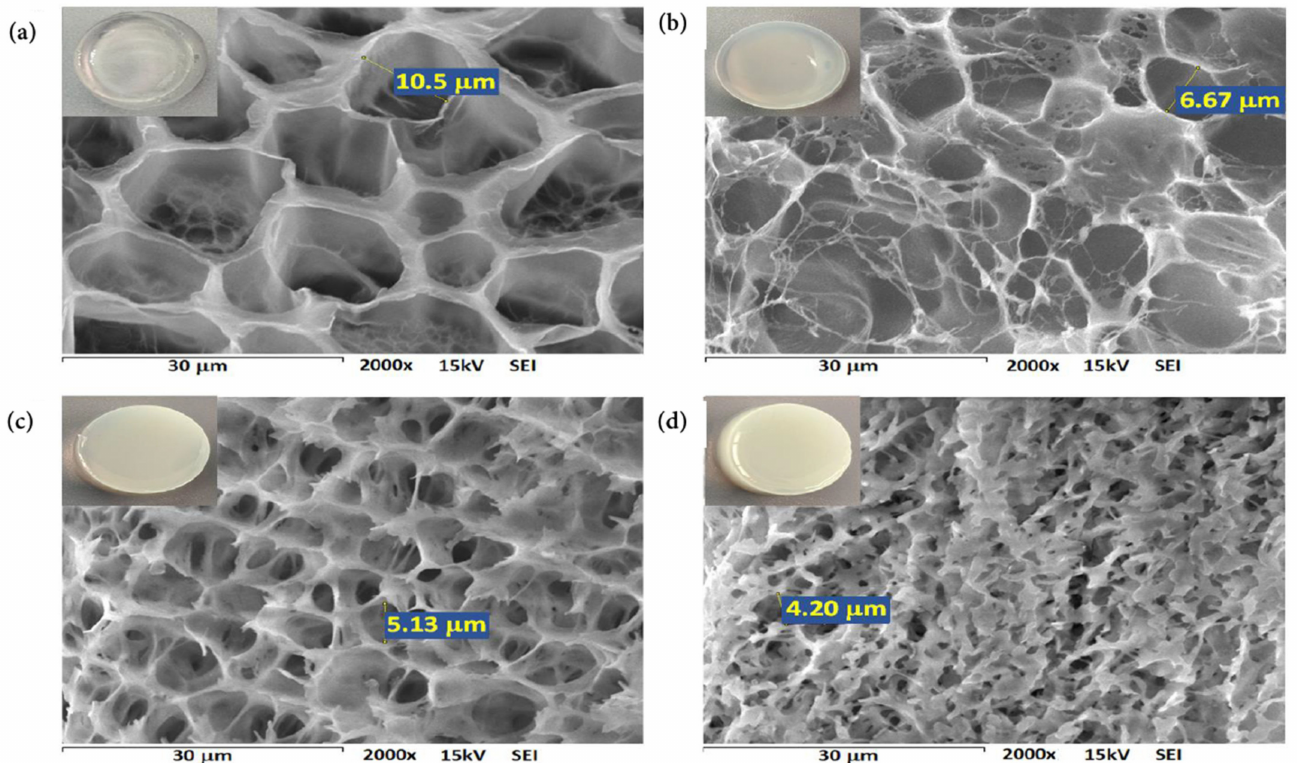
Figure 3. SEM micrographs of cross sections of PNIPAAm ( a ), s-IPN 1 ( b ), s-IPN 2 ( c ), and s-IPN 3 ( d ) hydrogels.